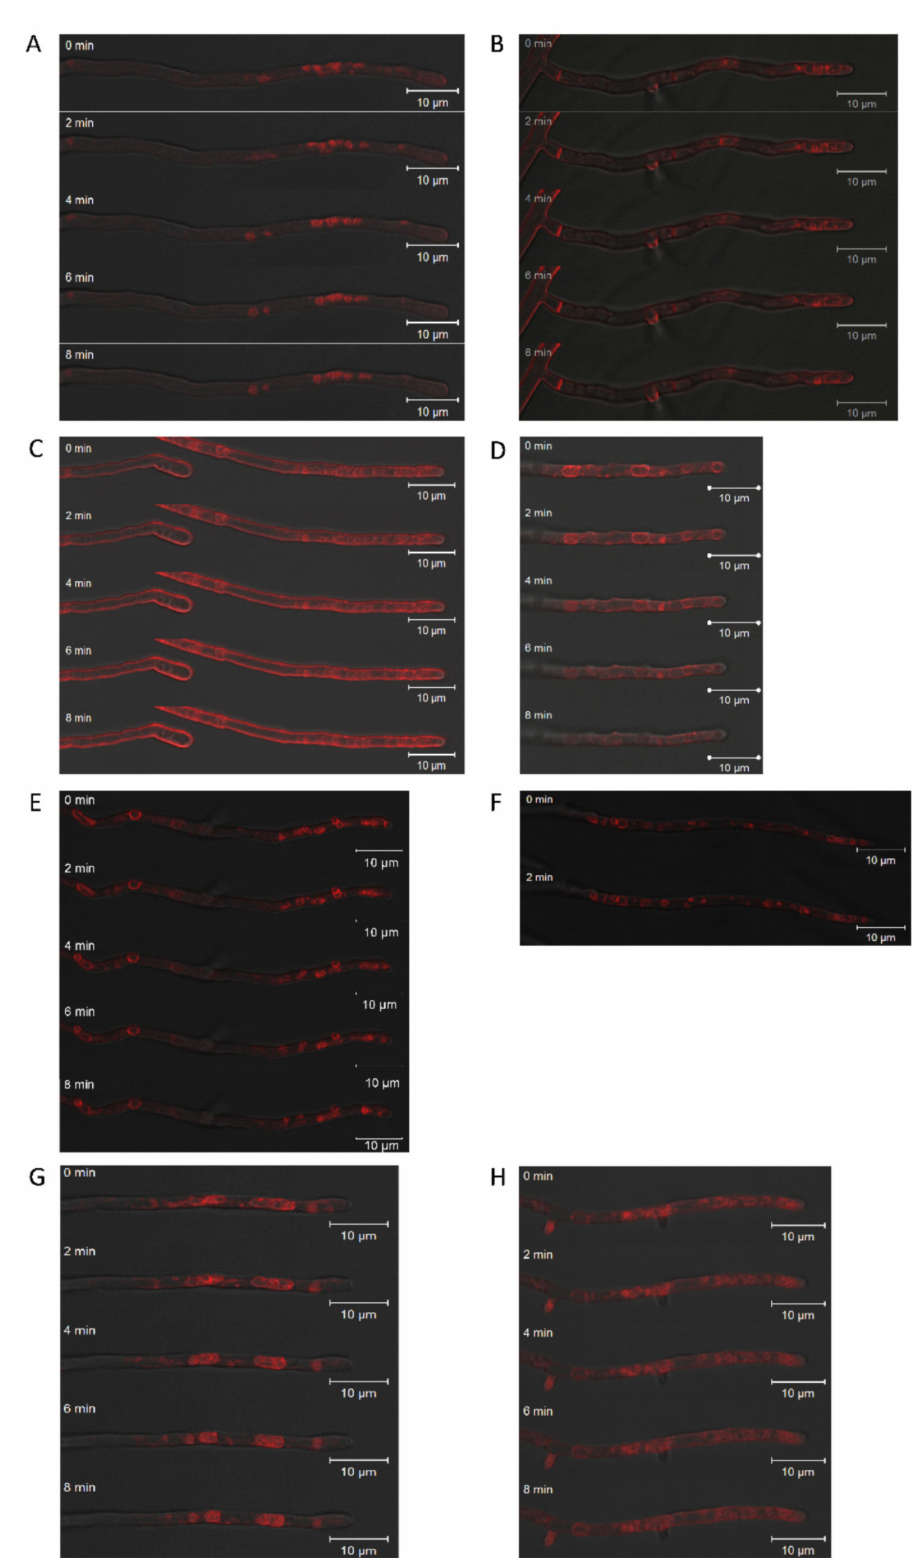
Figure 5. Effect of brefeldin A on intracellular and membrane trafficking. S. commune T33 ( A , B ), the empty vector control EVC1 ( C , D ), and overexpression transformants OEIMP4 and OEIMP6 ( E – H ) without ( A , C , E , G ) and with 5 µ m brefeldin ( B , D , F , H ) were compared. Membranes were stained using FM4-64 and monitored with time-lapse mode for 0–8